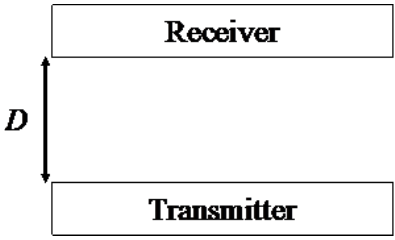
Figure 11. Consideration model (transmitter (Tx) and receiver (Rx)).